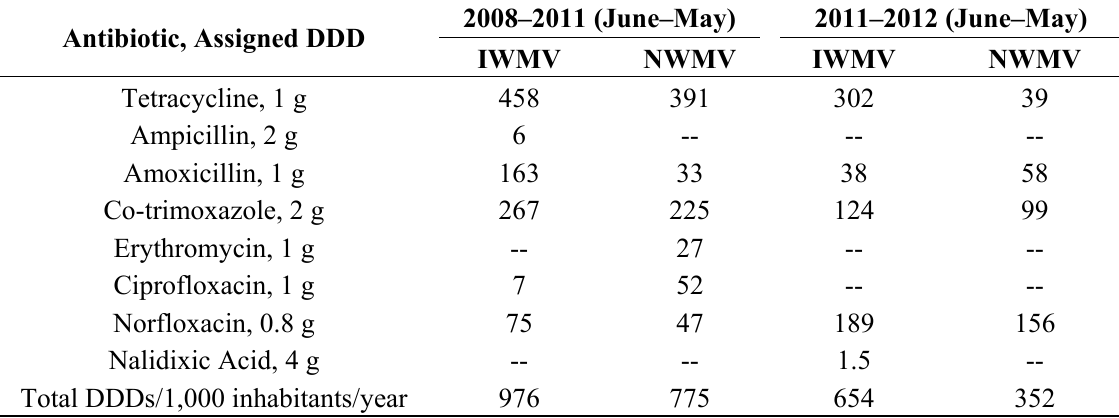
Table 3. Data on yearly average antibiotics delivered (DDDs/1,000 inhabitants/year) to sub-centres of Primary Health Centre during the years 2008–2011 and 2011–2012 in tribal villages with and without the implementation of integrated watershed management